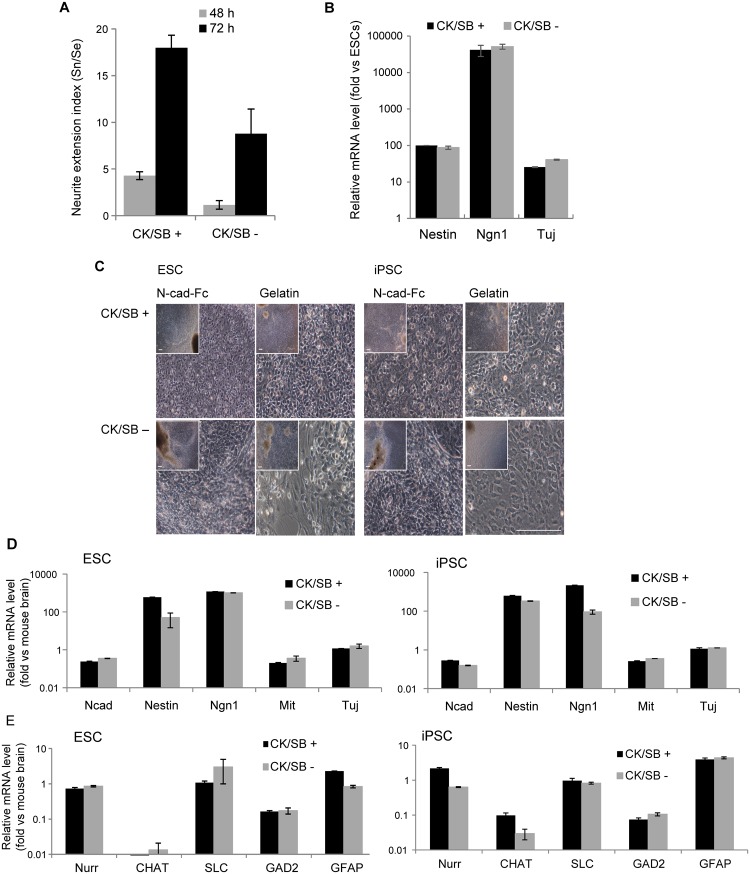
Neuronal differentiation on N-cadherin substrate without exogenous growth factors or inhibitors.
(A-B) ESCs cultured in suspension for 5 days with and without CKI-7 and SB-431542 (CK/SB) was further induced on N-cadherin substrate for 48 h in the absence of exogenous growth factors. The degree of neural conversion was analyzed by (A) neurite extension index and (B) qRT-PCR for relative mRNA expression of nestin, neurogenin 1 (Ngn1), and βIII-tubulin (Tuj). (C) Cellular phenotype of differentiated cells on N-cad-Fc and gelatin substrates at 20 days of differentiation was assessed by bright-field images. Scale bar: 200 μm. (D) Characterization of neural cells at 20 days of differentiation by the expression of neuronal progenitor cell markers, including N-cad, Nestin, Ngn1, Mitf and Tuj. (E) The relative mRNA expression level of neurotransmitter and subtype-specific genes (Nurr, CHAT, SLC, GAD2 and GFAP) in ESC- and iPSC-derived neuronal cells differentiated for 20 days on N-cadherin substrate. Abbreviation: ESCs, embryonic stem cells; iPSCs, induced pluripotent stem cells; Ngn1- Neurogenin 1; Mitf- Microphthalmia-associated transcription factor; N-cad, N-cadherin; Nurr- nuclear receptor-related factor; CHAT- choline acetyltransferase; SLC- solute carrier; GAD- glutamate decarboxylase; GFAP- glial fibrillary acidic protein.